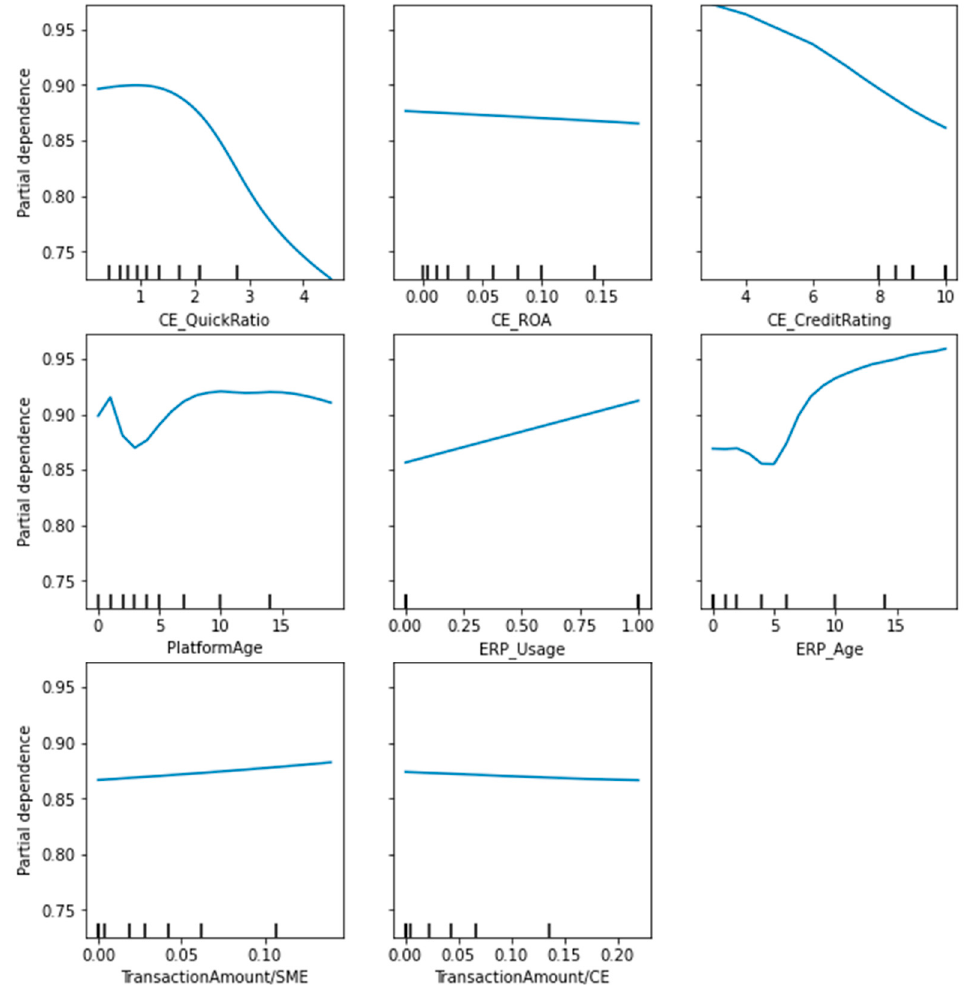
Figure 7. The PDP of DSCF features based on the XGBoost-MLP.